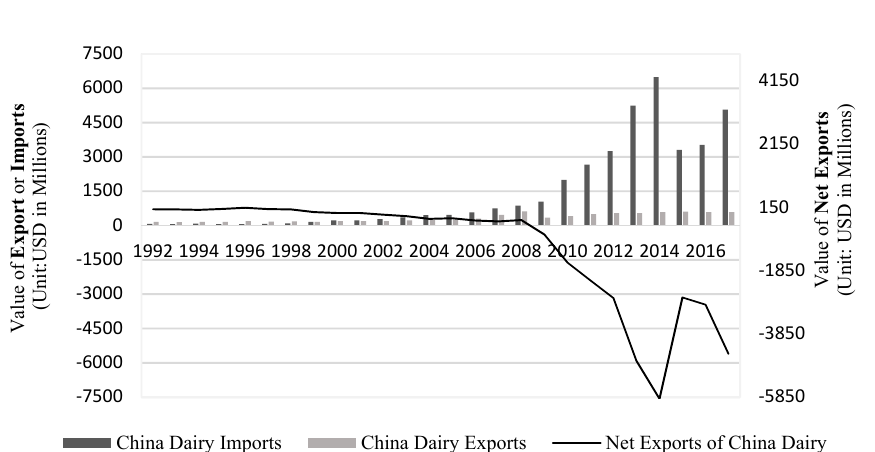
Figure 1. China Dairy Exports and Imports from World (Unit: USD in Millions).